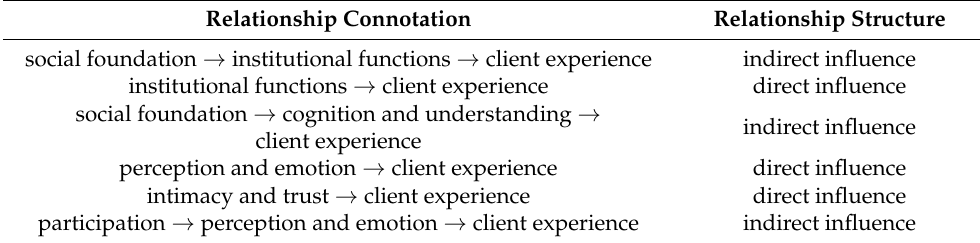
Table 5. Typical relationships among influencing factors.